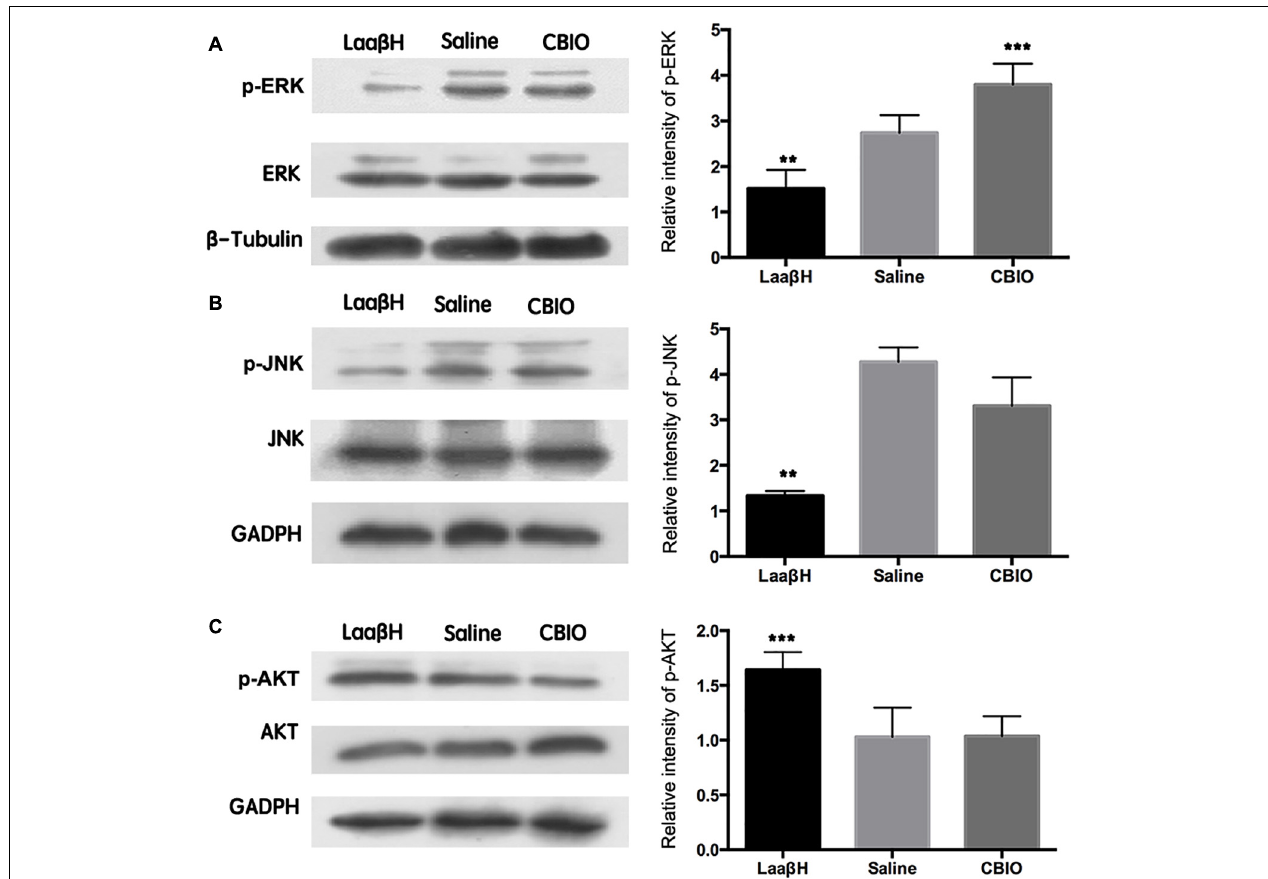
FIGURE 6 | Effects of manipulating SR activity on the expression and phosphorylation of ERK, JNK, and AKT. (A) Western blots of p-ERK/ ERK in Laa β H, saline, and CBIO treated rats, and the quantification of p-ERK. (B) Western blots of p-JNK/JNK in Laa β H, saline, and CBIO treated rats, and the quantification of p-JNK. (C) Western blots of p-AKT/AKT in Laa β H, saline, and CBIO treated rats, and the quantification of p-AKT. N = 3 rats in each group. Notice that Laa β H decreased and CBIO increased the phosphorylation of ERK. ∗∗ P < 0.01, ∗∗∗ P <